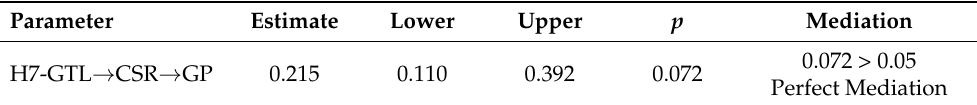
Table 5. The mediation effect of CSR (developed by the authors using SPSS and AMOS software).